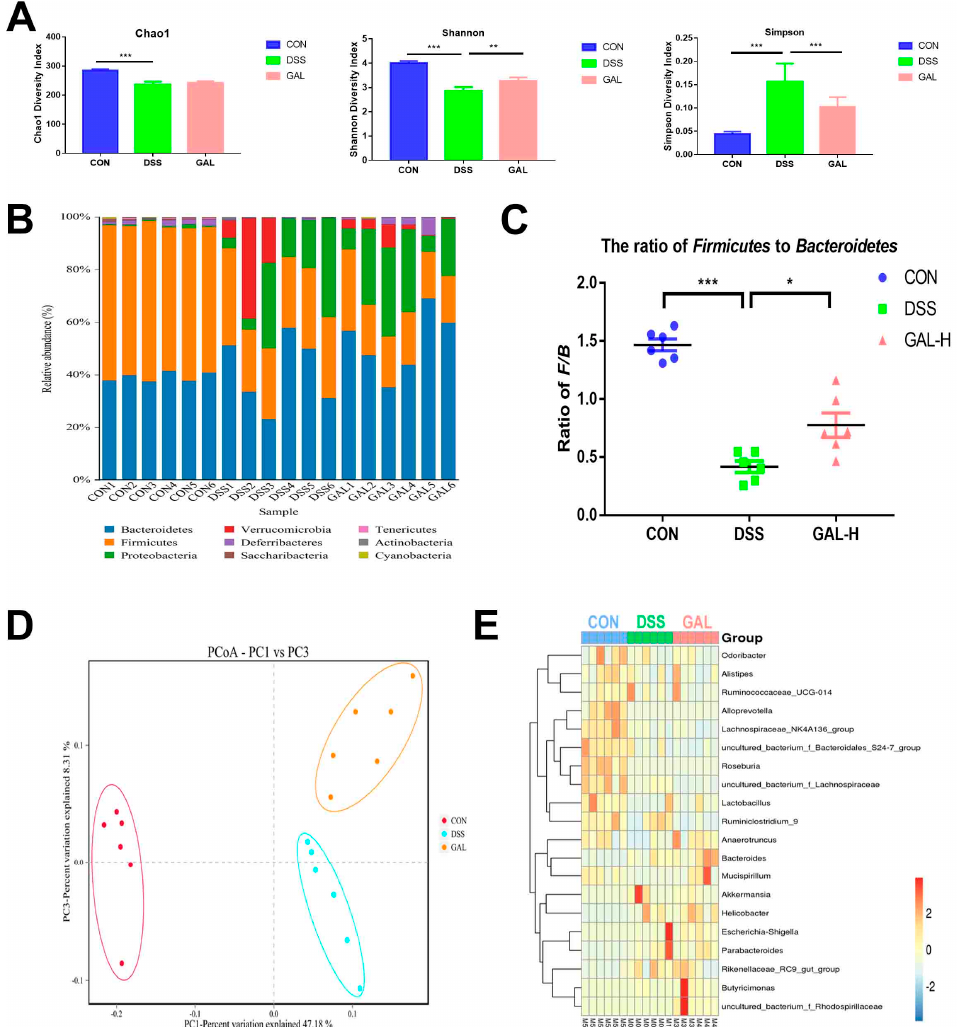
Figure 4. Galangin administration modulated gut microbiota in colitic mice. Mice cecal digesta were